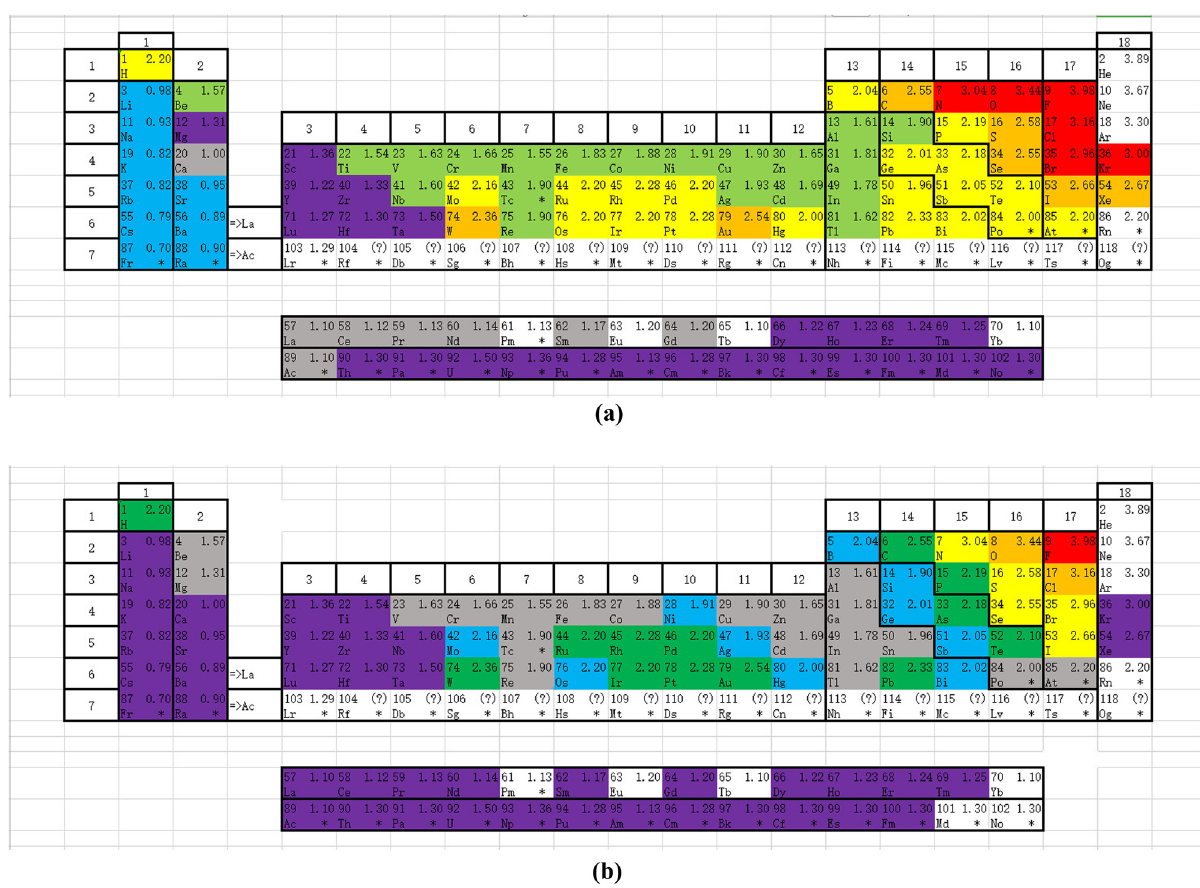
Figure 13: Seven groups clustered by χ p and PR. ( a ) Seven groups clustered by χ p . ( b ) Seven groups clustered by